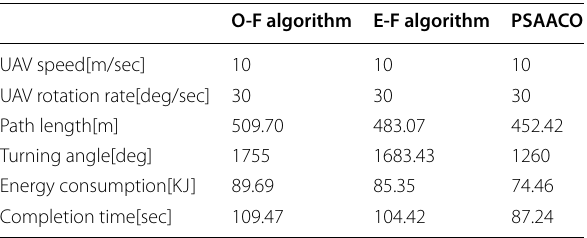
Table 13 Experiments on area 2 for performance comparison between PSAACO and algorithm in